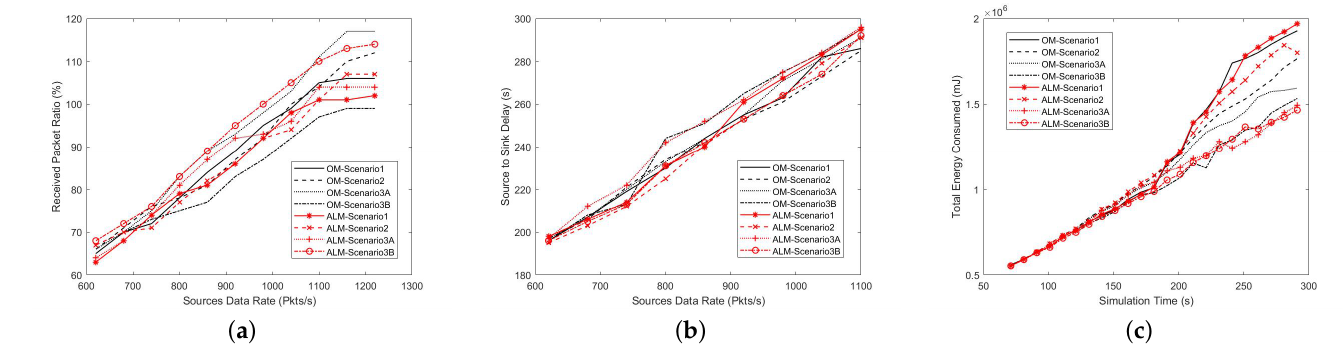
Figure 10. Evaluation graphs of eNPA algorithm. ( a ) Average Throughput, ( b ) Source to Sink Delay, ( c ) Total Energy